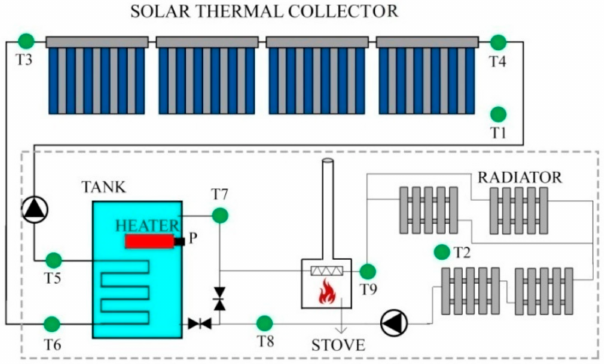
Figure 1. Schematic diagram of the triple